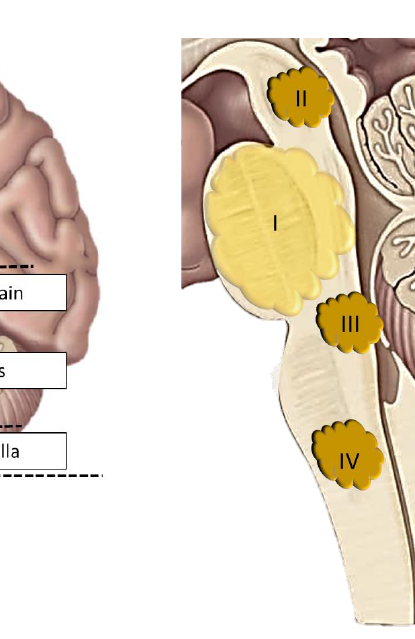
Figure 1 - Anatomical location of the brainstem and its classic subdivisions . Figure 2 - Choux et al. classification for brain stem